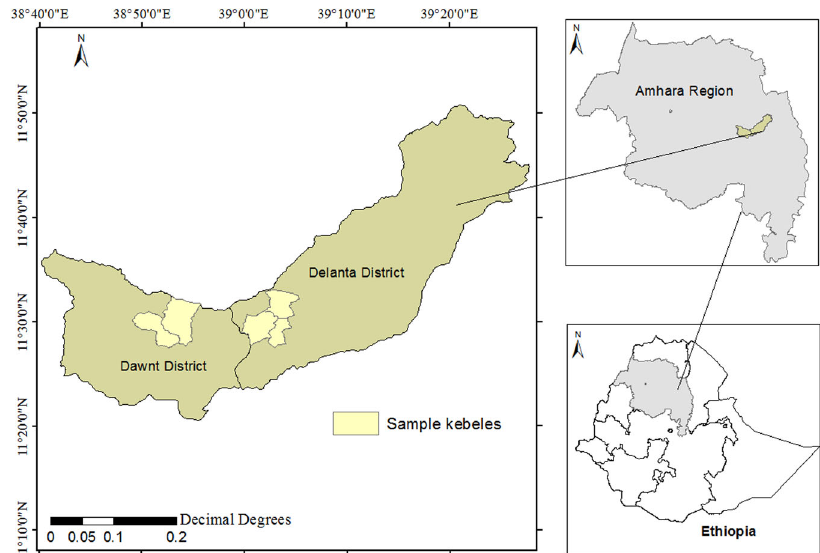
Fig. 1 Map of the study districts. Map of the study districts showing location of Amhara region (Light Grey) in Ethiopia (White), Delanta and Dawnt districts (Lime Dust) in Amhara region (Light Grey) map and Sample kebeles (light yellow) in Dawnt and Delanta districts (Source of the data/shape fi le: Ethiopian Central Statistical Authority, 2007).